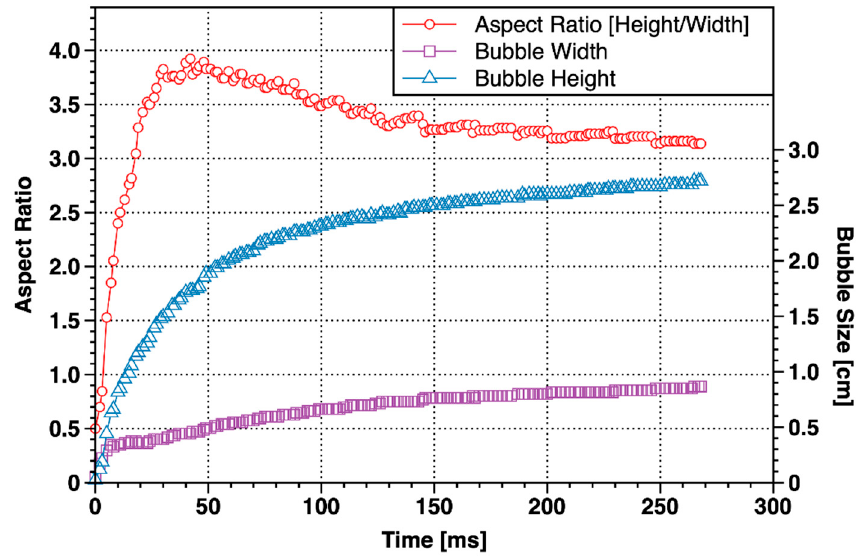
Figure 6. Changes in shape of the major bubble with time.